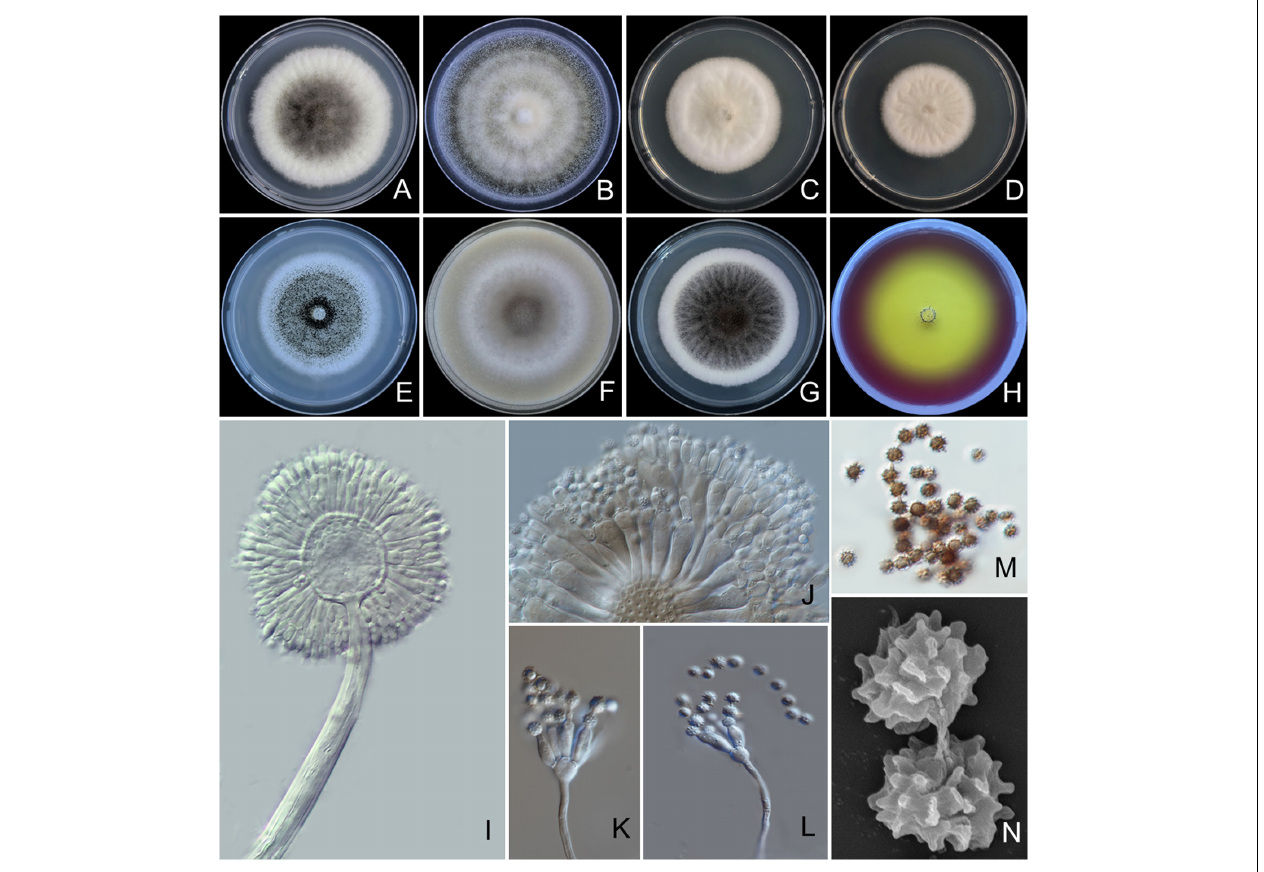
FIGURE 4 | Aspergillus pseudotubingensis SDBR-CMUO2 (holotype). Colonies incubated at 25 ◦ C for 7 days. (A) PDA, (B) CZA, (C) CYA, (D) CYAS, (E) MEA, (F) OA, (G) YES, (H) CREA, (I–L) conidiophores under light microscopy, (M) conidia under light microscopy, (N) conidia as seen using SEM. Scale bars: (A–H) 10 mm, (I–M) 10 µ m, and (N) 5 µ